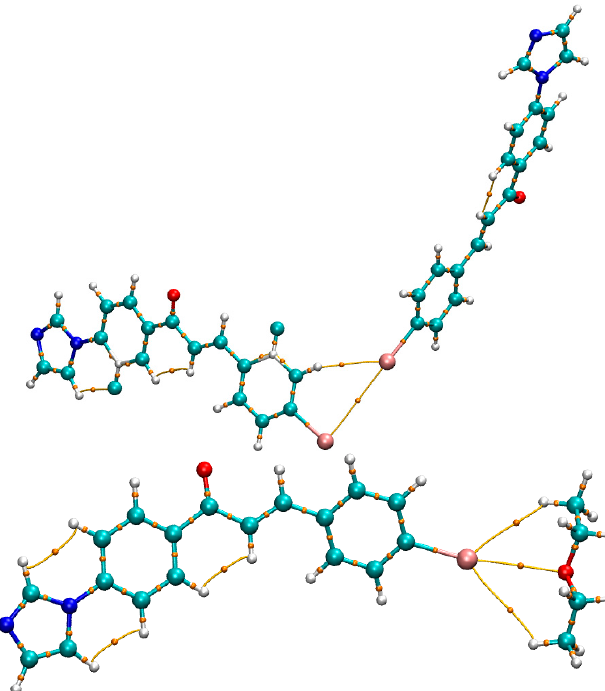
Figure 6. The molecular fragments {(4I-L)···(4I-L)} ( top ) and {(4I-L)···(Et 2 O)} ( bottom ) showing the atoms in molecules (AIM) analysis indicating the position of the bond electron density critical points (BCP) of the type (3, − 1) as small orange spheres together with calculated bond paths (yellow lines).